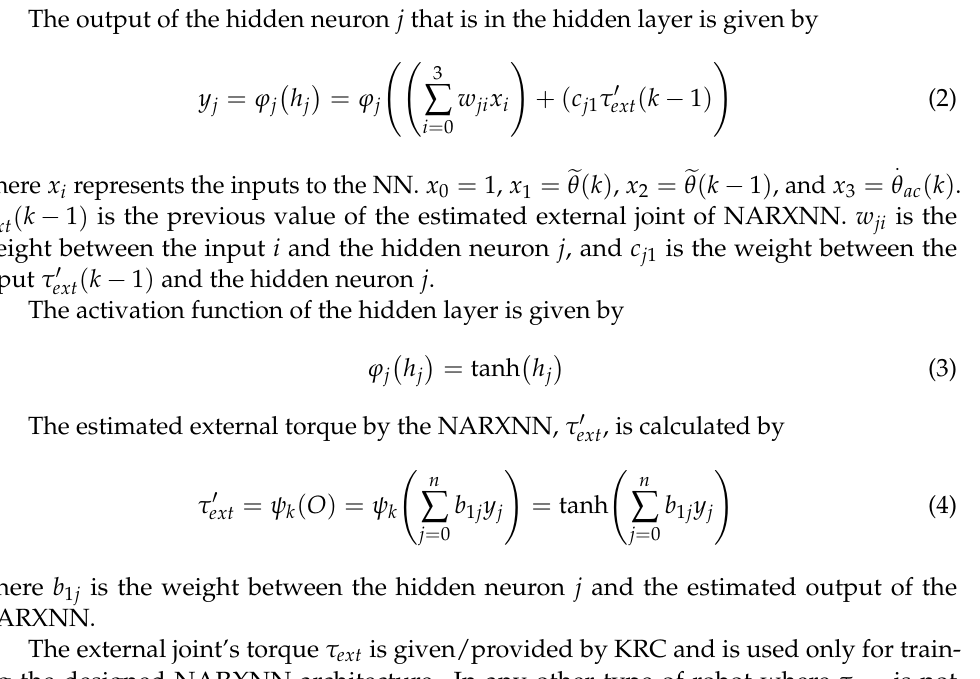
Figure 5. The developed NARXNN structure. The inputs are the current error of the position, the previous error of the position, and the actual velocity of the joint. The output is the estimated external joint’s torque.